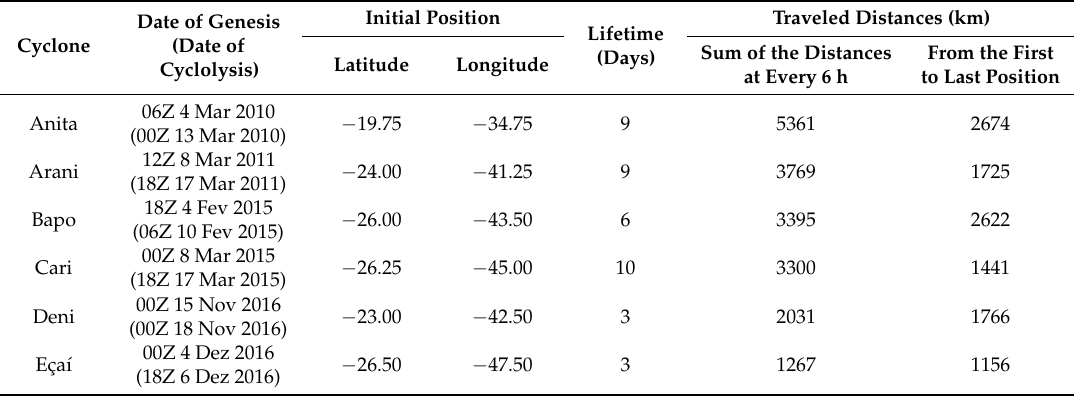
Figure 1. Trajectory of the six named subtropical cyclones based on the minima of relative vorticity at 925 hPa. The circle indicates the first position of each system. The purple box defines the southeastern coast of Brazil called RG1. The acronyms RS, SC, PR, SP, RJ, and ES indicate the Brazilian states, respectively, Rio Grande do Sul, Santa Catarina, Paran á , S ã o Paulo, Rio de Janeiro, and Esp í rito Santo. Table 2. Characteristics of the six named subtropical cyclones over the South Atlantic Ocean (SAO). Dates of genesis and cyclolysis, and coordinates of the initial position were based on the cyclonic relative vorticity at 925